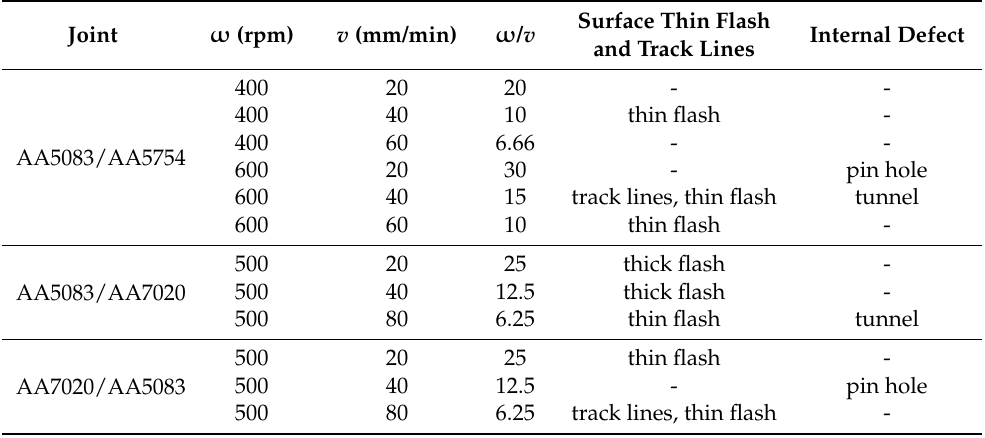
Table 5. Visual inspection of the macrostructure of cross section of the FSWed joints and the welding conditions ( ω and v